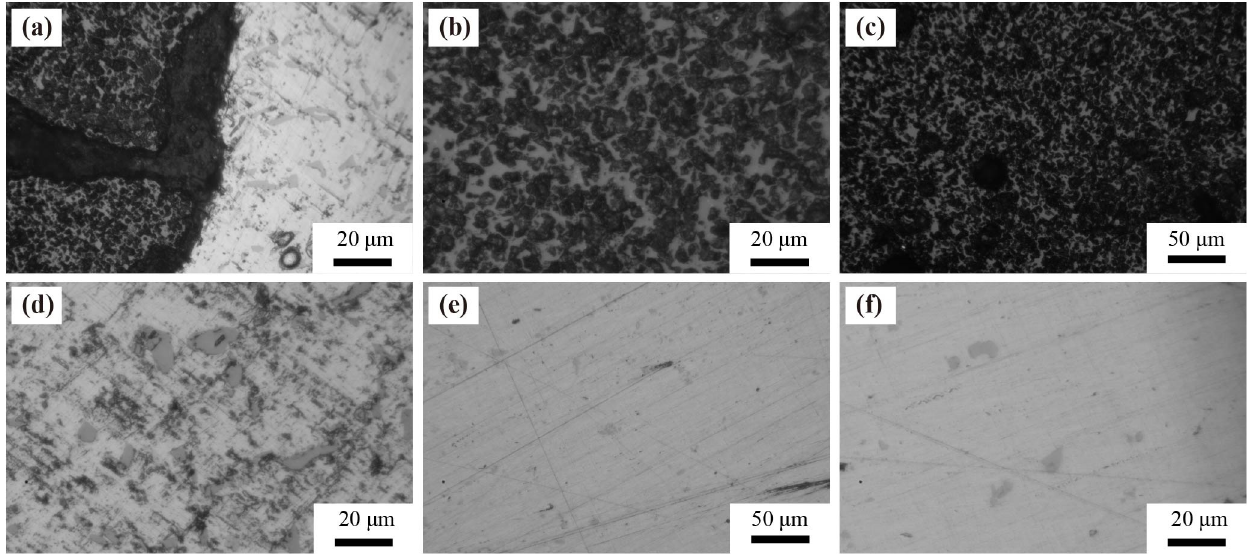
Figure 4. Optical micrographs of two materials after Tafel corrosion: ( a – d ) SiC 3D /6061Al; ( e , f ) 6061Al alloy.